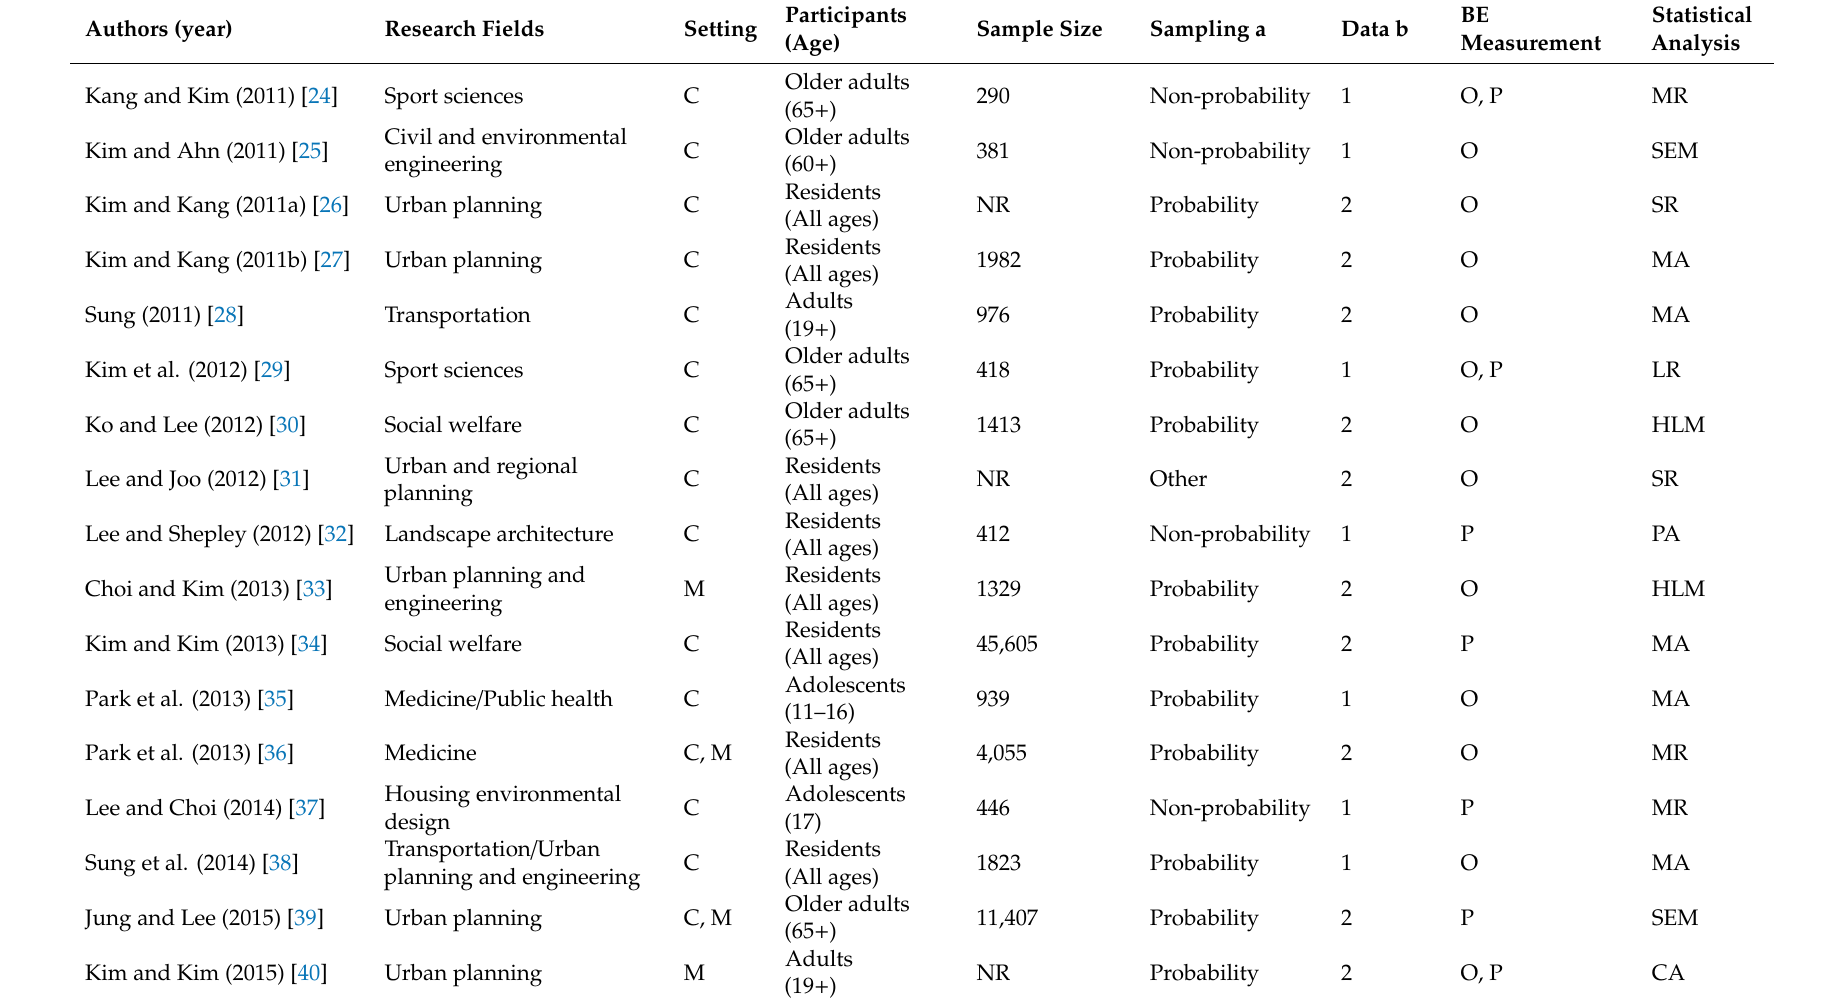
Table 2. Characteristics of the reviewed